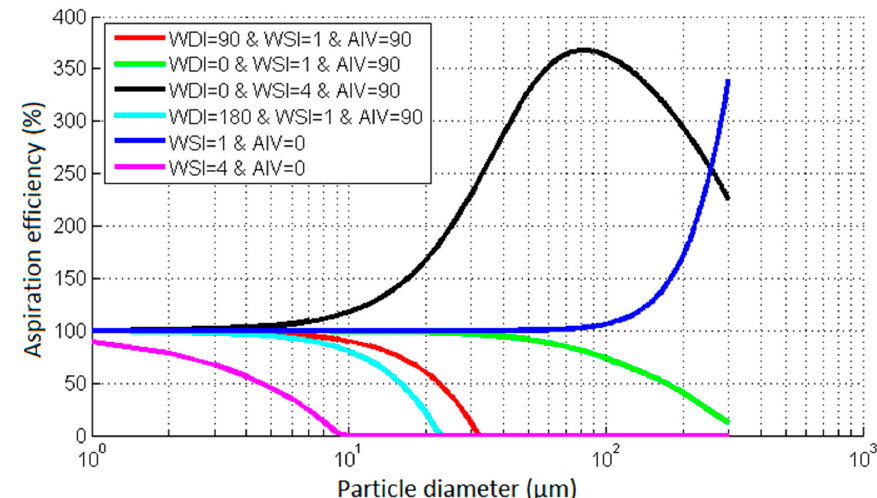
Figure 7. Sensitivity test on aspiration efficiency versus particle diameter for several configurations of inlet-relative wind direction (WDI) and speed (WSI), and angle of inlet attack from the vertical (AIV).